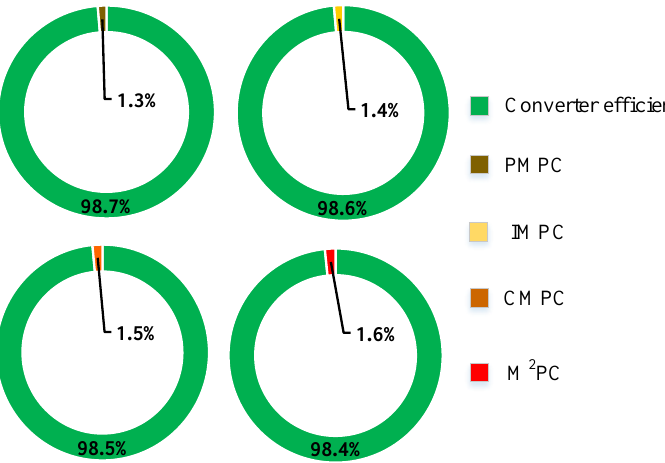
Figure 12. Simulated maximum converter efficiency and the total loss amount of each MPC alogrithm at 8